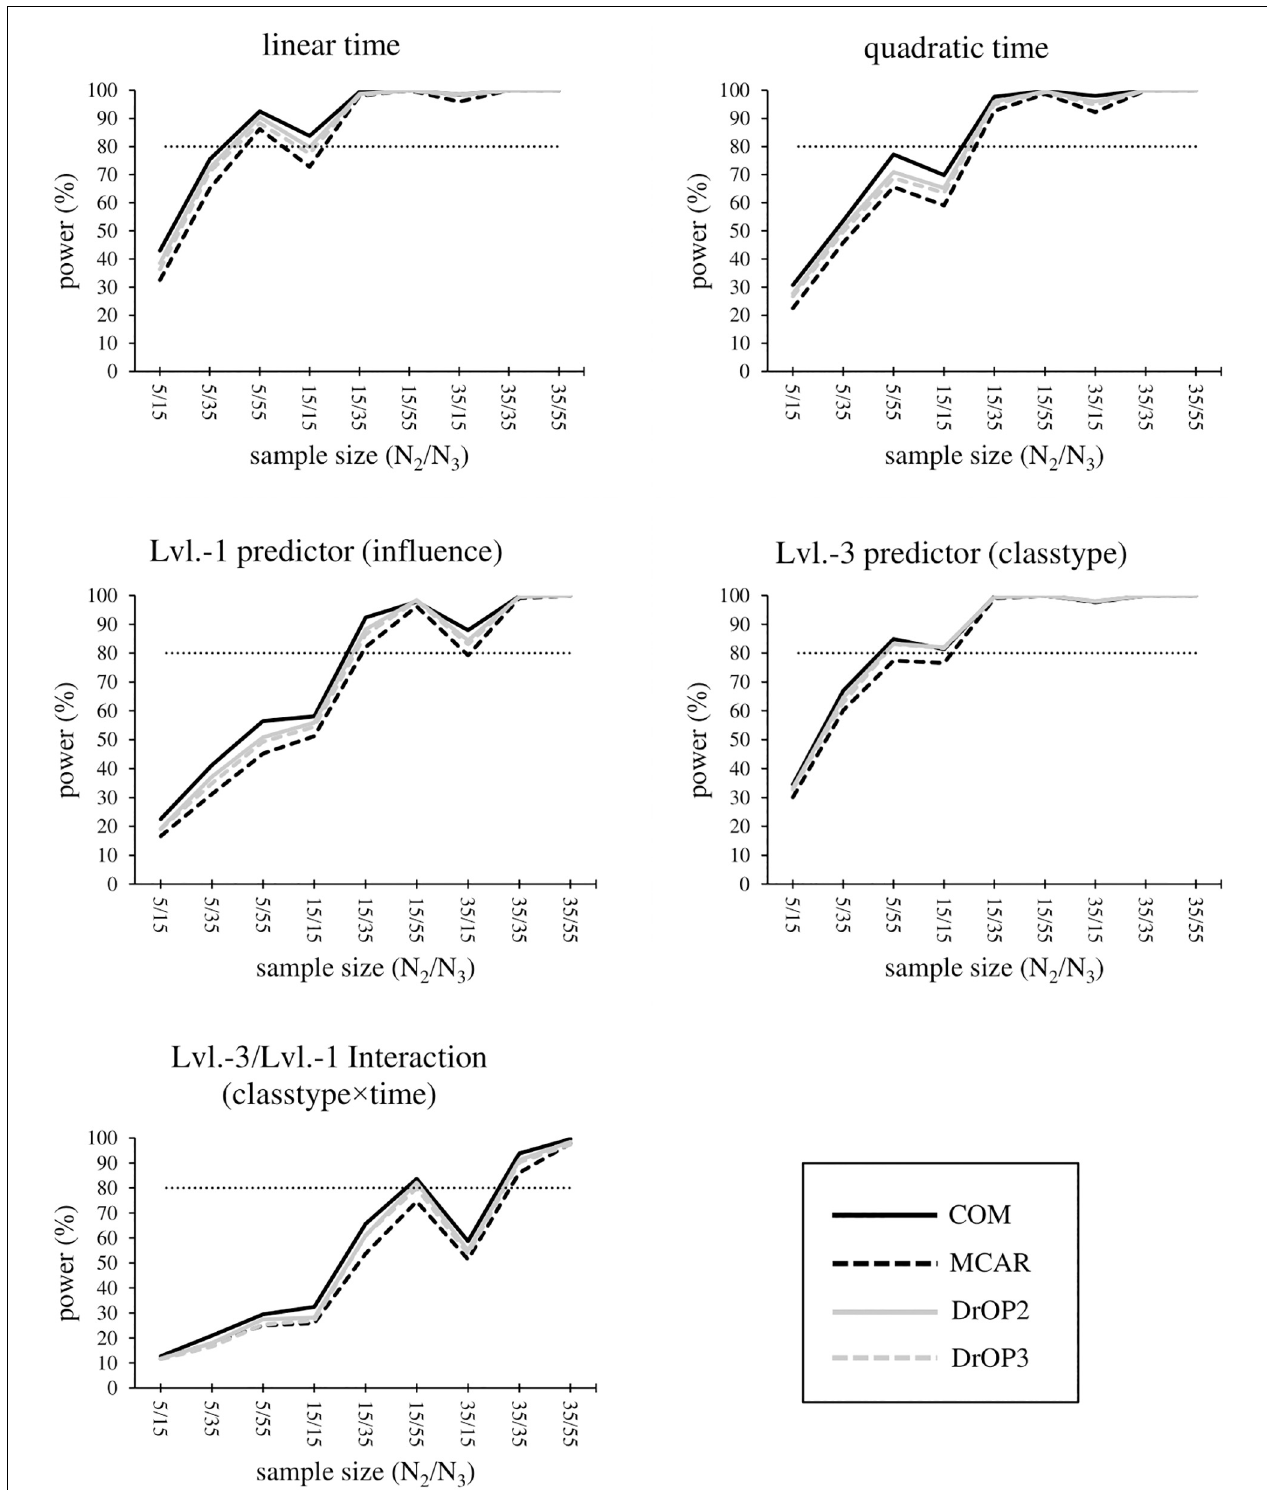
FIGURE 2 | Statistical power for the time effect, level-1 predictor influence, level-3 predictor classtype, and the cross-level interaction of influence × classtype. The sample size condition is displayed as “level-2 sample size/level-3 sample size,” e.g., 5/15 corresponds to “5 students each in 15 sampled classrooms.” The missing value conditions (see section “Materials and Methods” and Table 6 ) are displayed by the type and shade of lines. The light dotted line marks the minimum sufficient power of 80%.